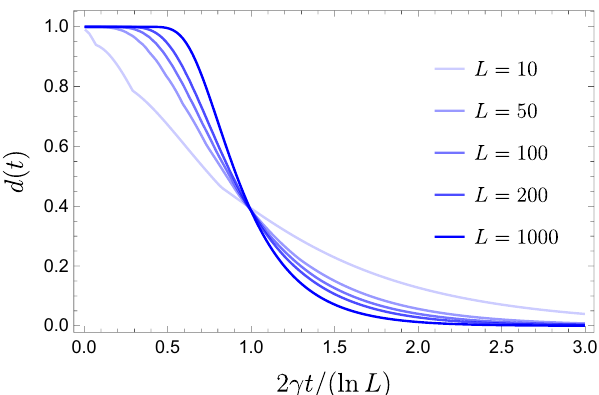
Figure 1: Distance to equilibrium of the classical random walk on the hypercube { 0,1 } L . As L increases, a sharp cutoff develops, with the distance jumping from 1 to = ln L 0 around a time t mix 2 γ